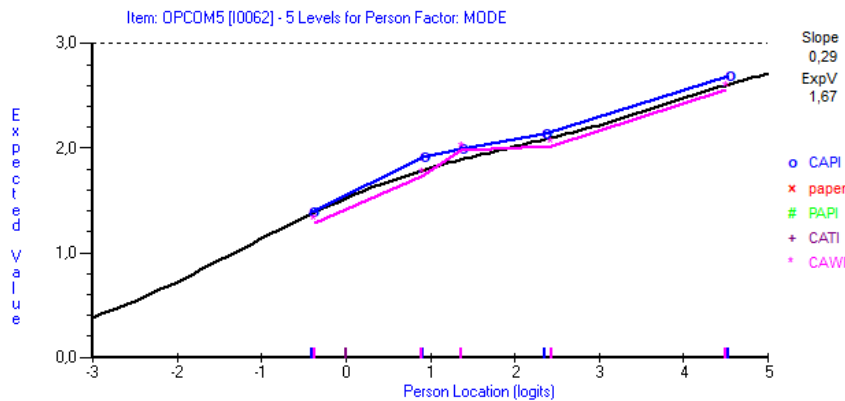
Figure 4. Graphical comparison between means of CAPI and CAWI in Slovenian data for item COM5 (“express your personal views and preferences to your doctor”).